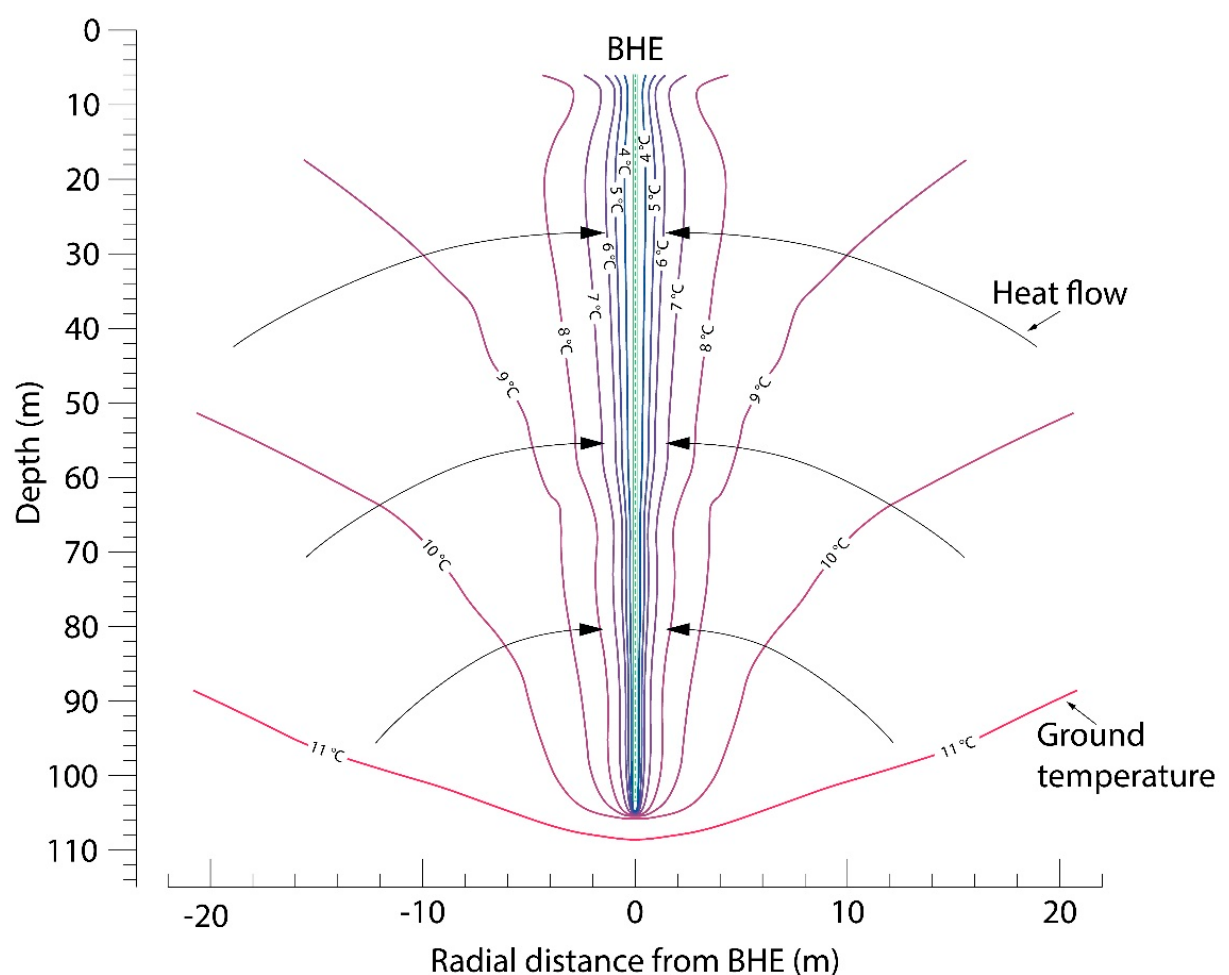
Figure 12. Calculated isotherms around a 105 m deep BHE during the coldest period of the heating season 1997 in Elgg/ZH, Switzerland. The radial heat flow in the BHE vicinity is around 3 W/m 2 . Data from [7] are plotted.